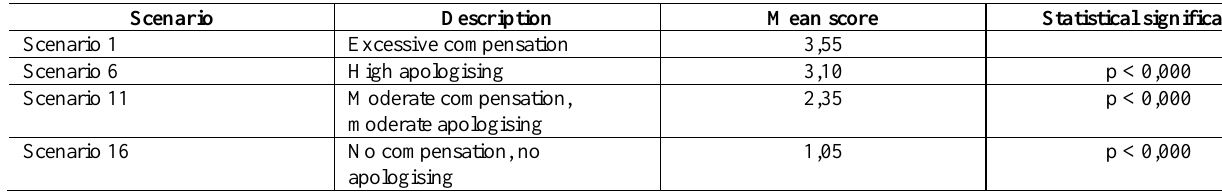
Table 4: Pre-test results compensation: restaurant